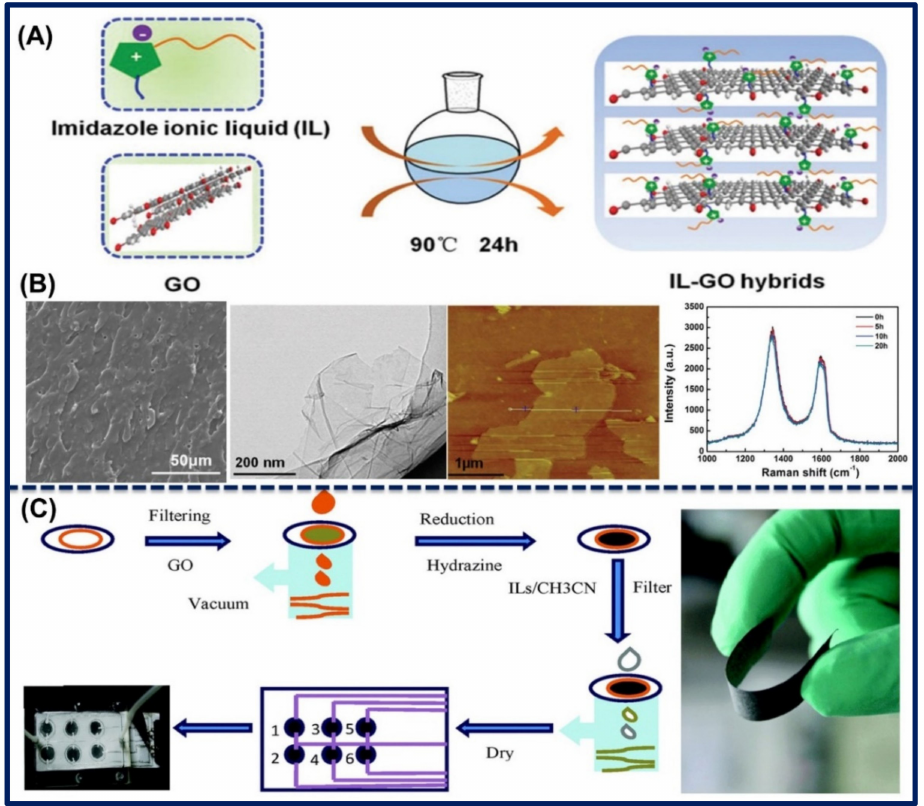
Figure 8. ( A ) Schematic of the preparation of GO-ILs hybrids nanocomposites. ( B ) SEM, TEM, and SPM images of GO-ILs hybrids and stability study of the GO-ILs hybrid aqueous solution using the Raman spectrum. Reprinted with permission from Ref. [76]. Copyright 2018, Royal Society of Chemistry. ( C ) The procedure for the preparation of flexible, paper-supported RGO-ILs sensor array. Reprinted with permission from Ref. [77]. Copyright 2016, Royal Society of